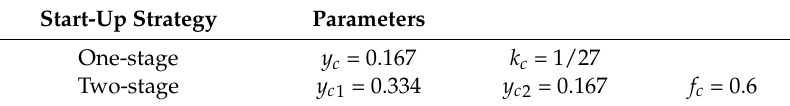
Table 7. DGVC parameters selected by